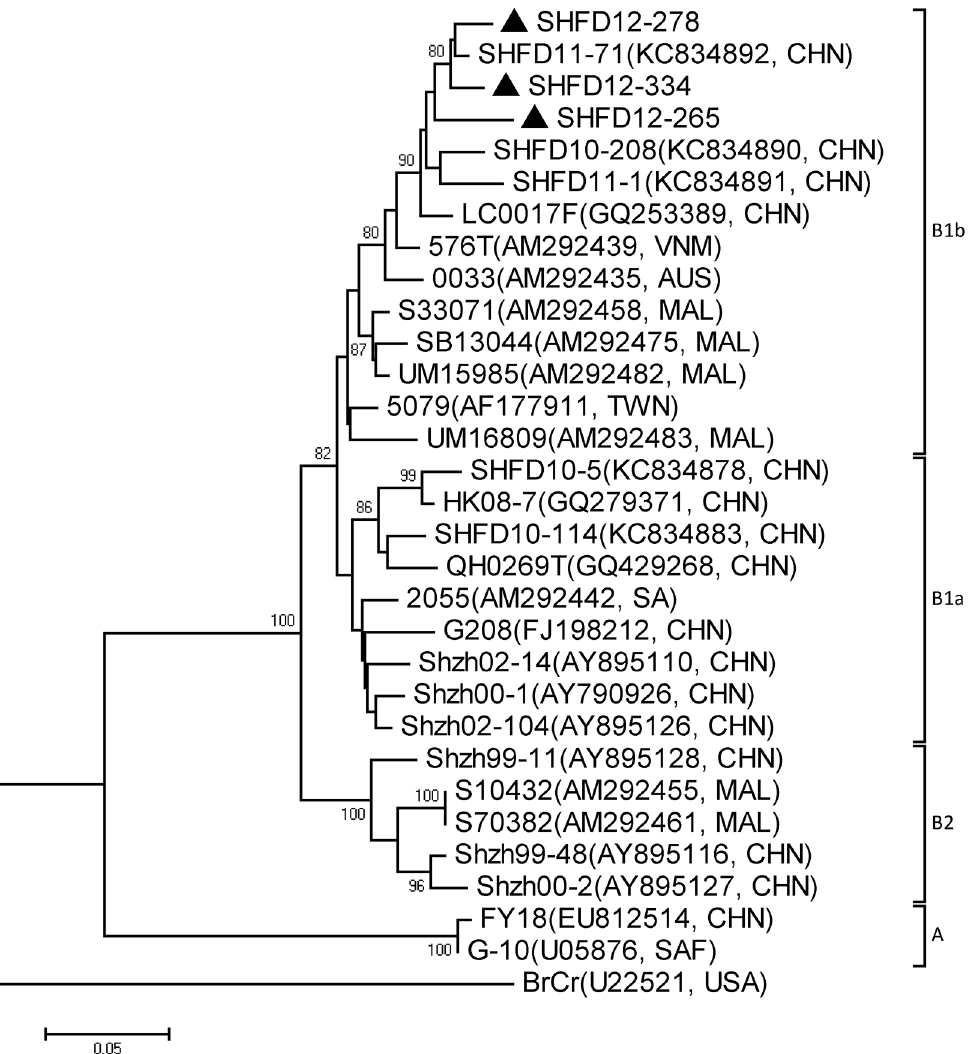
Fig 6. Phylogenetic analysis with the neighbor-joining method with a 1000-bootstrap re-sampling based on the alignment of the 399 nucleotide VP1 gene of 3 Shanghai CA16 strains. The strains labeled with ▲ were obtained in our study.